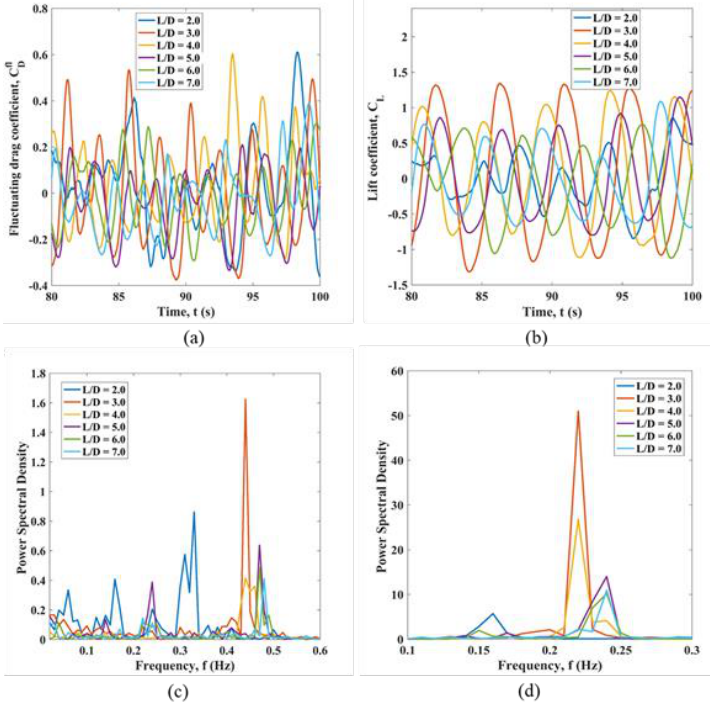
Figure A4. Fluid force coefficients for cylinder 5 immersed in the uniform flow: ( a ) time history of the fluctuating drag coefficient; ( b ) time history of the lift coefficient; ( c ) the drag coefficient FFT; ( d ) the lift coefficient FFT.